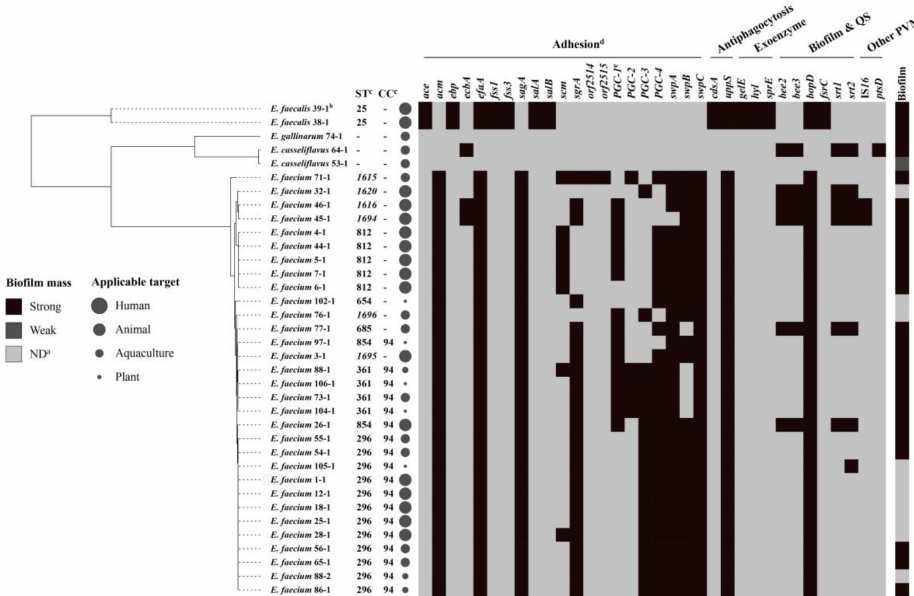
Figure 1. Virulence genes, MLST (multilocus sequence typing), and biofilm mass profiles of 36 Ente- rococcus spp. isolates from the probiotics. Note: (a) ND, no biofilm mass; PVM, putative virulence marker. (b) The rule of strain name is the first number and represents the originated probiotic product, and the latter number represents the isolated strain. (c) CC, clonal complex; the new STs (sequence types) were labelled in italic; -, ST or clonal complex cannot be assigned. (d) In the heatmap, black color indicates strain carrying the corresponding virulence gene. (e) PGC-1, a complete PGC-1 cluster, including pilA , pilE , pilF , orf1903 , orf1905 , and orf1916 ; PGC-2, a complete PGC-2 cluster, including orf2008 , orf2009 , and orf2010 ; PGC-3, a complete PGC-3 cluster, including pilB , pilE , pilF , orf2568 , orf2570 , and orf2571